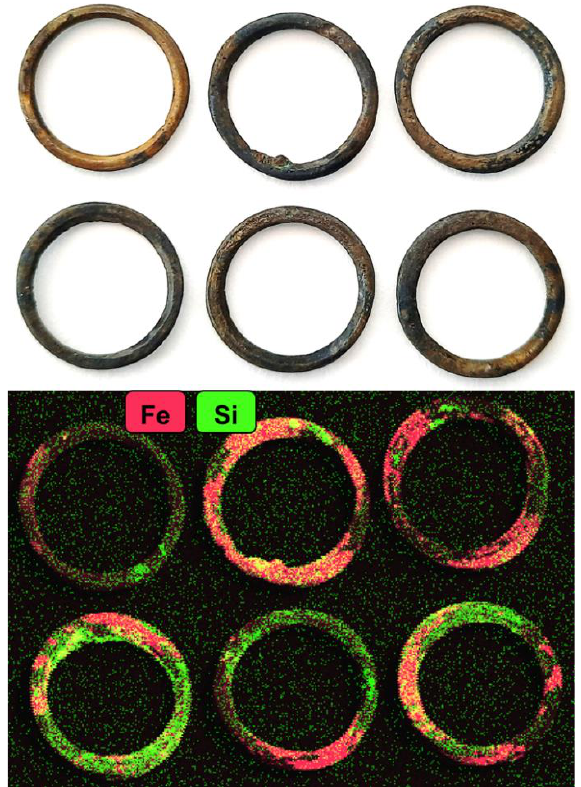
Figure 4. Copper alloy rings (top) and coloured µXRF maps of the elements accumulating on the surface patina and on concretion residues (Fe and Si, respectively) (bottom).